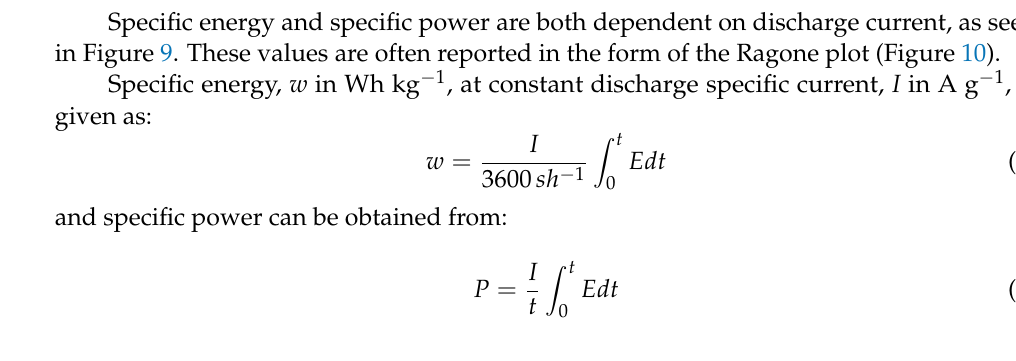
Figure 10. Ragone plot of PANI electrode vs. SCE. Insert: specific capacitance over specific current.